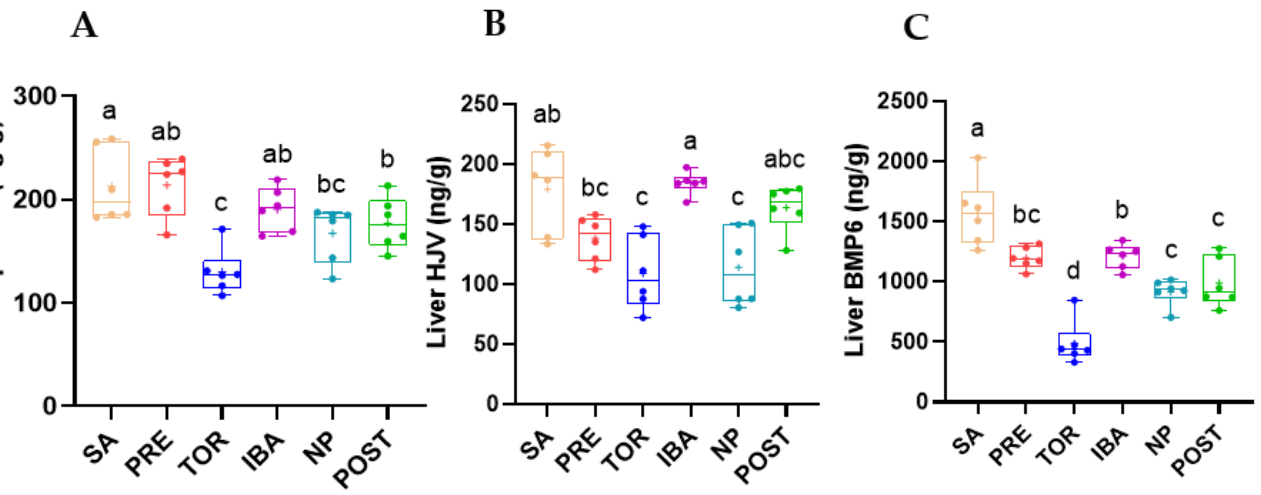
Figure 7. Changes in expression of hepcidin ( A ), hemojuvelin (HJV) ( B ), and bone morphogenetic protein 6 (BMP-6) ( C ) in liver in different groups. SA, summer active group; PRE, pre-hibernation group; TOR, torpor group; IBA, interbout arousal group; NP, near post-hibernation group; and POST, post-hibernation group. Boxes represent upper and lower quartiles, middle horizontal line represents median, plus sign represents average, lines extending from upper and lower ends represent upper and lower edges, respectively, and points represent individual sample values ( n = 6). Superscripts with different letters indicate significant differences ( p < 0.05) among groups by Tamhane or Sidak test. Superscripts with same letters denote no significant differences ( p > 0.05).